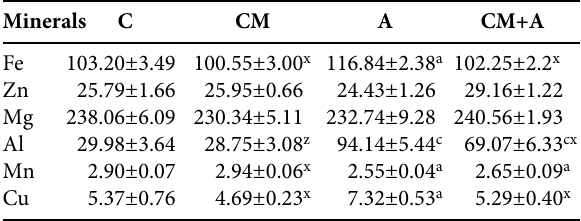
Table 1: Liver mineral levels (ppm)